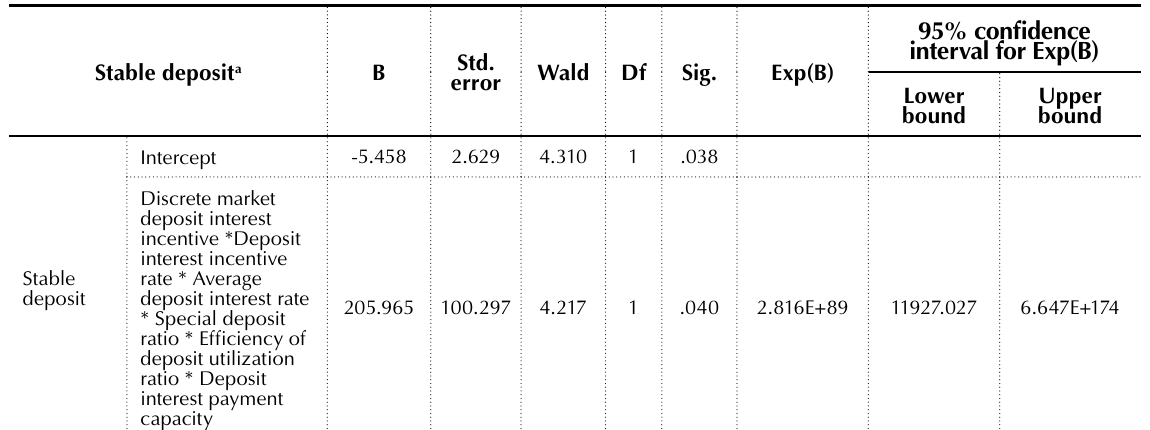
Table 29. Parameter estimates of stable deposit